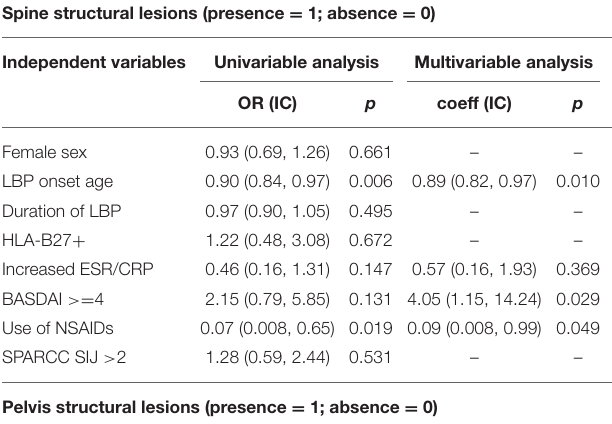
TABLE 6 | Baseline predictors factors of spine or pelvis structural lesions at T24. Spine structural lesions (presence = 1; absence =